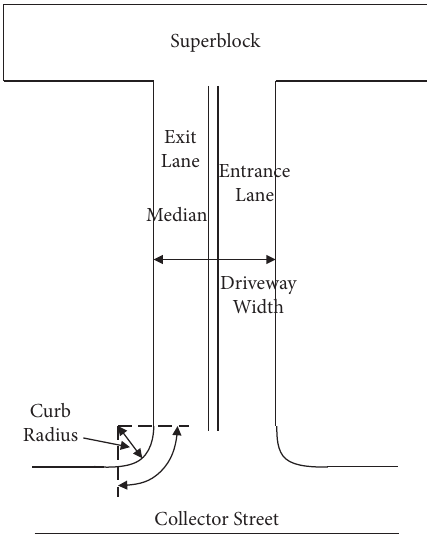
Figure 1: Width and curb radius of the driveway.